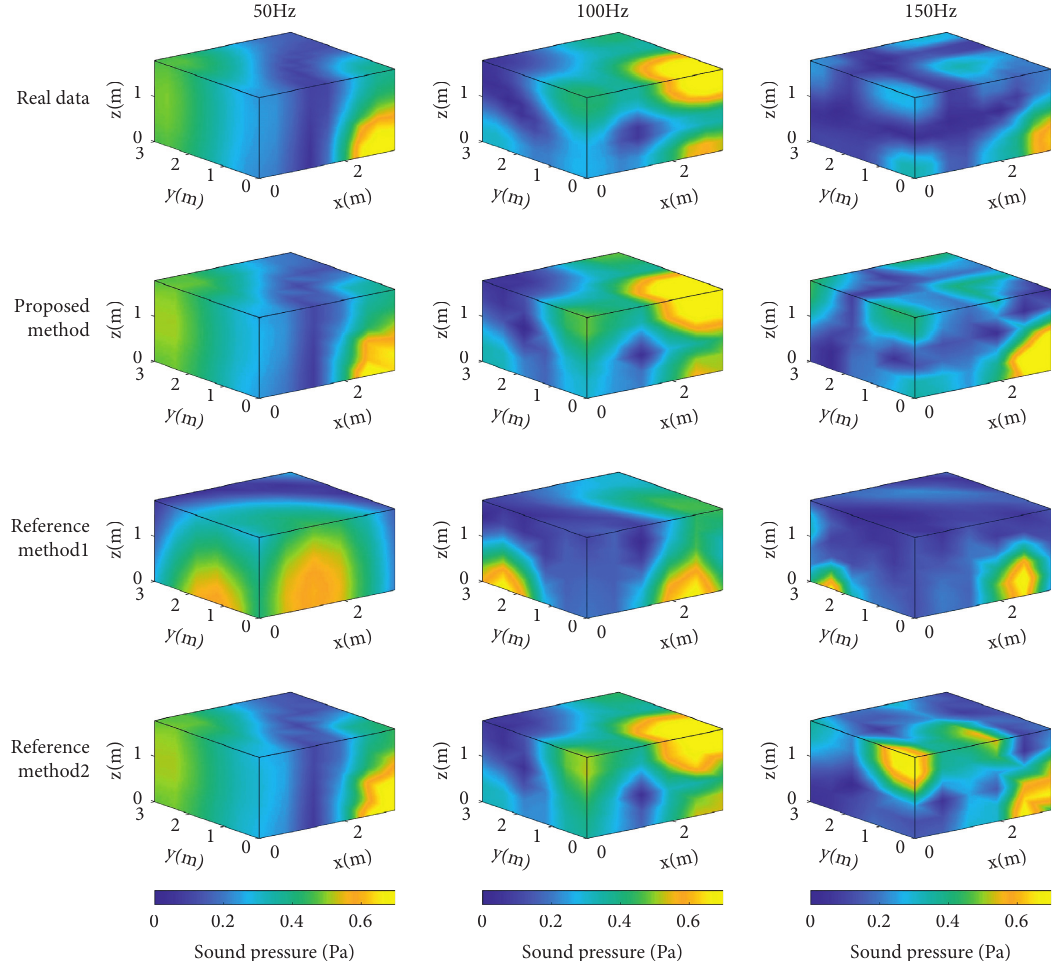
Figure 4: Sound pressure distributions obtained by the proposed method and two reference methods at 50Hz, 100Hz, and 150